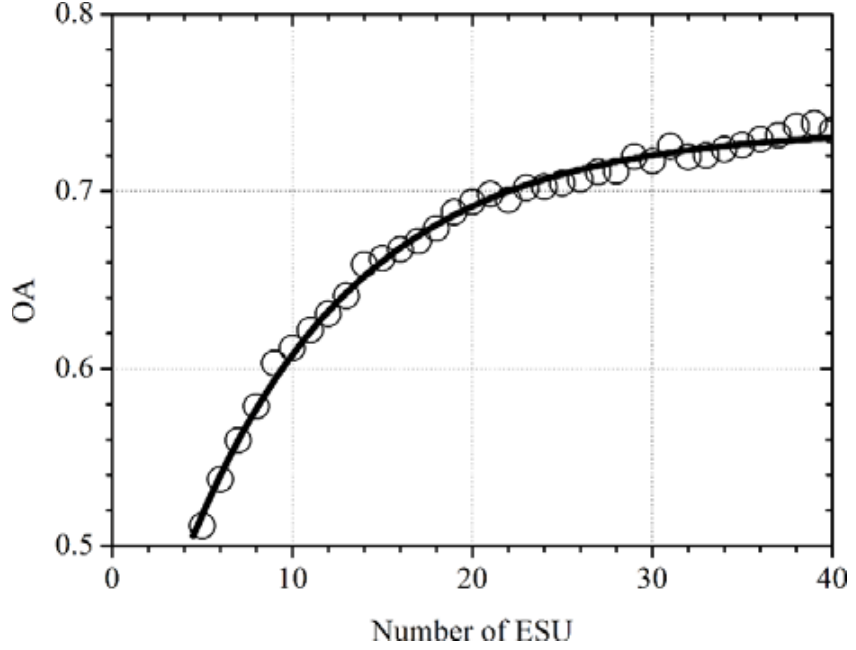
Figure 2. Overlapping area (OA) of the NDVI histogram distributions for the sampled and entire study area as a function of the number of Elementary Sampling Units (ESU).